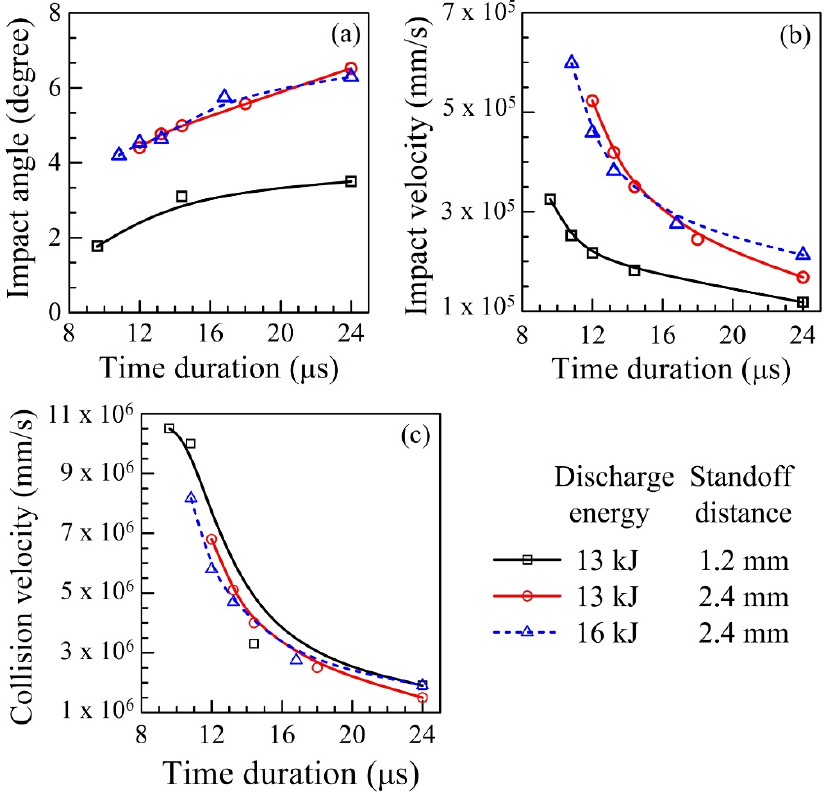
Figure 8. Computed impact ( a ) angle and ( b ) velocity of the flyer, and ( c ) flyer–target collision velocity variation with time, for different values of the standoff distance and applied discharge energy.